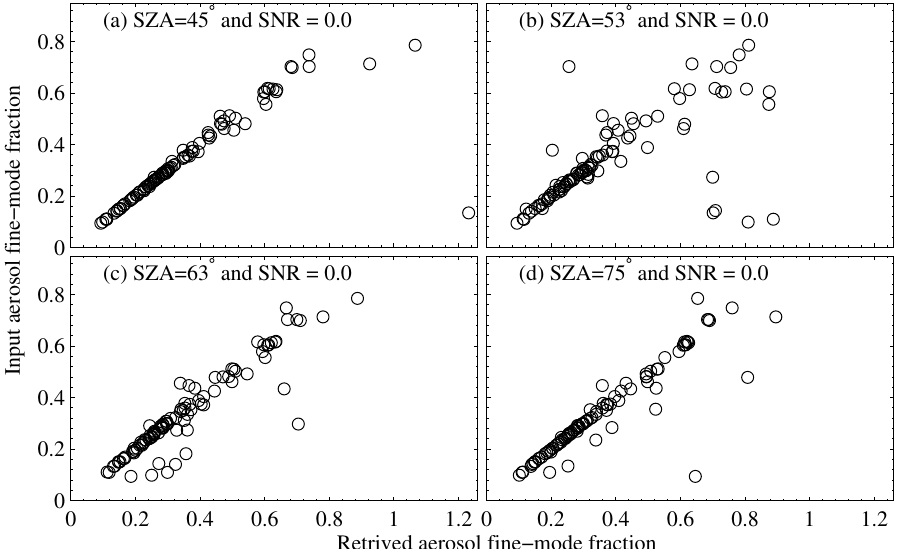
Figure 6. Comparison between input values and retrieved values for the volume fraction of fine-mode aerosol particles for different solar zenith angles